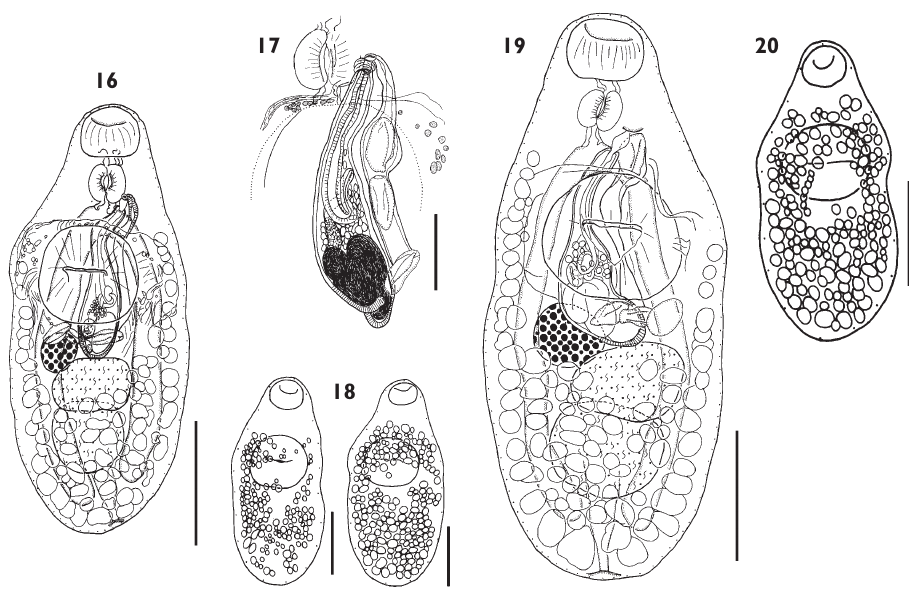
Figs 16-18. Macvicaria fl exuomeatus n. sp. ex Go- niistius gibbosus . 16. Whole-mount ventral view. 17. Terminal genitalia. 18. Dorsal distribution of vitell- ine follicles. Scale bars : 16, 18, 250 μm; 17, 100